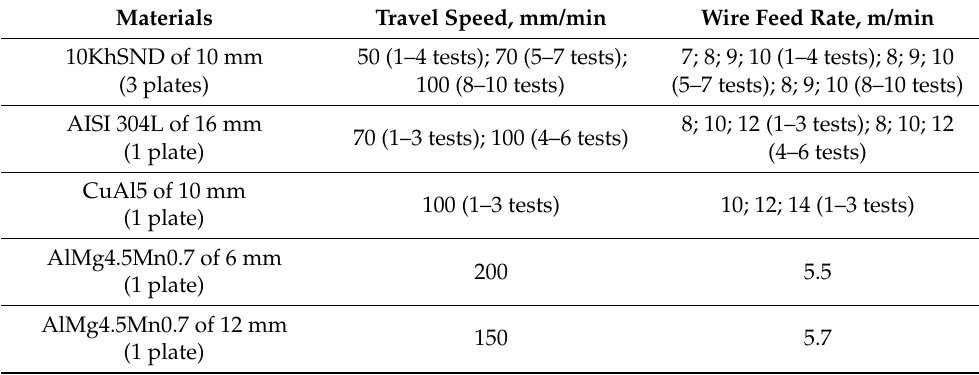
Table 3. Parameters of underwater wet cutting.